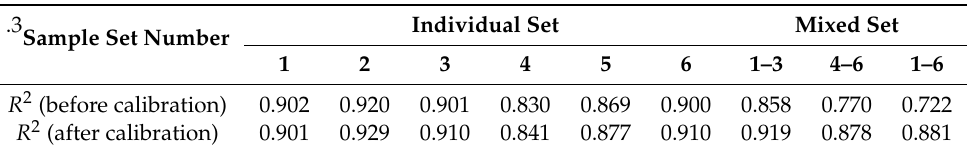
Table 6. The R 2 of linear fitting functions between psychoacoustic annoyance (PA) and MA for individual sets and mixed sets before and after calibration.